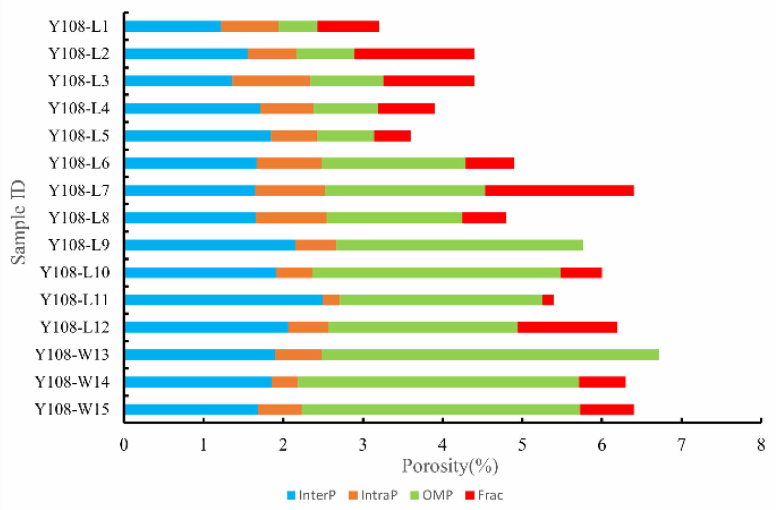
Figure 6. Total porosity constitution of the Wufeng–Longmaxi Fm shale samples. InterP—interparticle pores; IntraP—Intraparticle pore; OMP—Organic matter pores; Frac—fracture. According to calculations, matrix porosity ranges from 3.06% to 7.67% (mean: 5.08%), while fracture porosity ranges from 0 to 1.14% (mean: 0.29%) (Figure 5) organic matter (OM) porosity ranged from 0.63% to 4.58% (average: 2.73%) in the matrix porosity composition, while brittle mineral intergranular porosity ranged from 0.92% to 1.55% (average: 1.2%) and clay mineral intragranular porosity ranged from 0.41% to 1.82% (average: 1.15%).